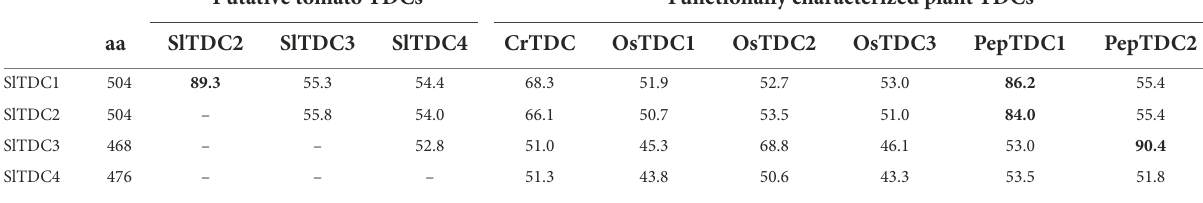
TABLE 1 Properties of the tomato TDC candidates and their relationship with other plant TDCs. Putative tomato TDCs